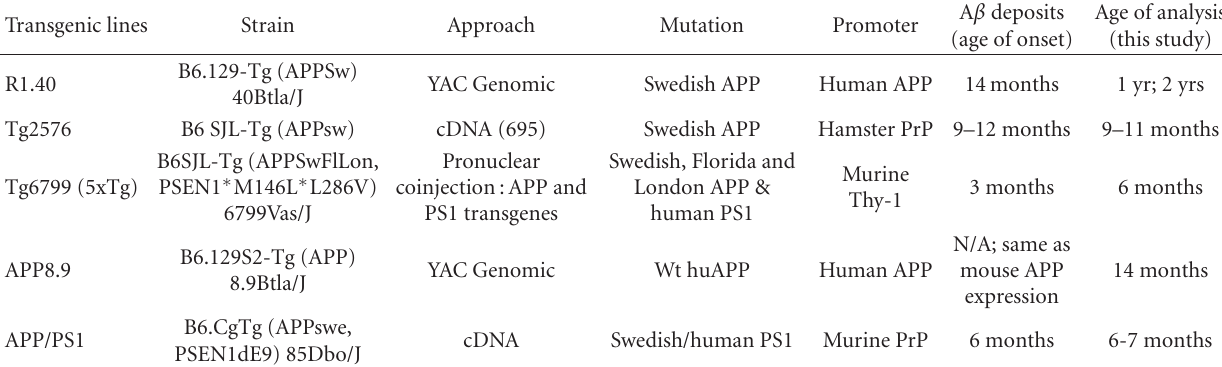
Table 1: Transgenic mouse lines used in this